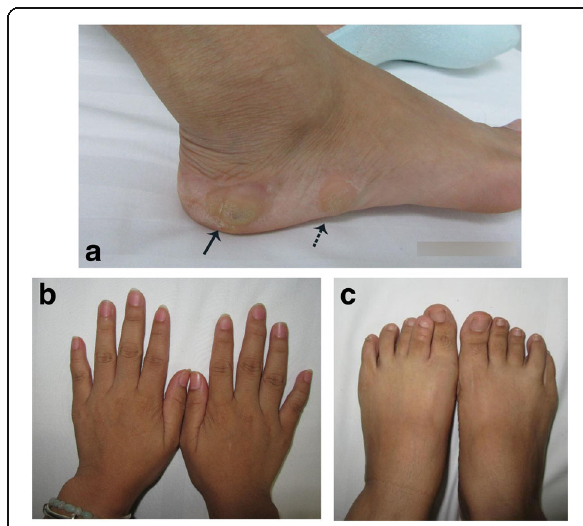
Fig. 1 The gross pictures of the patient. See two skin-colored nodules (arrows) on lateral side of the right foot ( a ). Note that the bigger one (solid arrow) shows a little blue in color. The patient ’ s fingers ( b ) and toes ( c ) were deformed due to